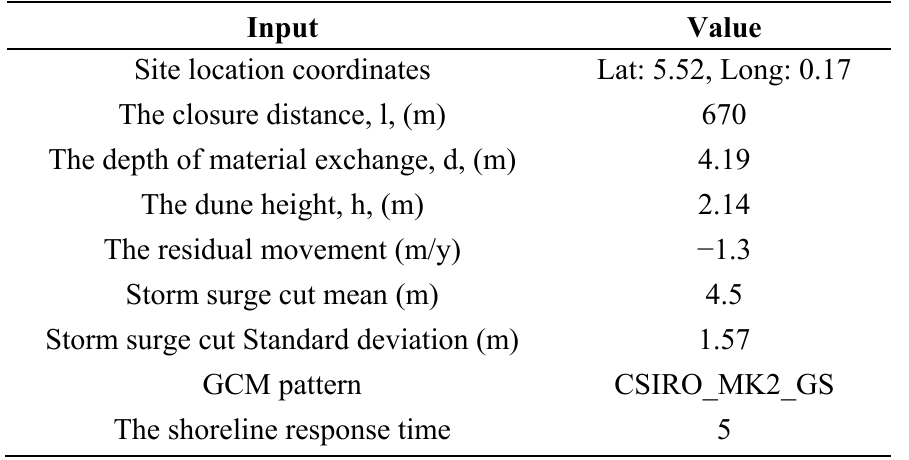
Table 1. CoastCLIM model input parameter for the Dansoman coastal